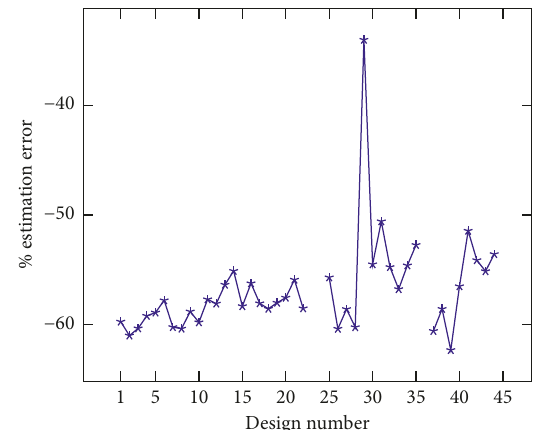
Figure 9: The estimation percentage error for slice, LUT, and FF when compared to the measured values.